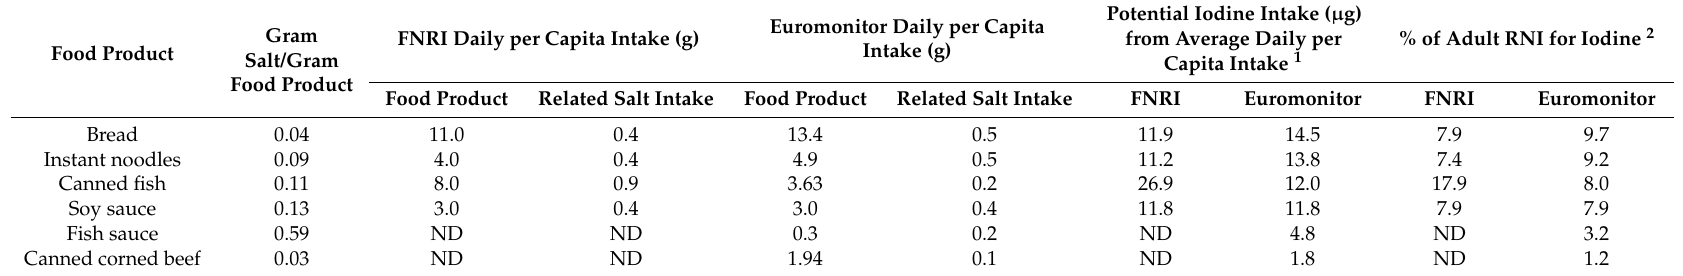
Table 4. Potential adult iodine intake from selected products if all salt used in production is iodised at the level of 30 mg/kg iodine, the Philippines.